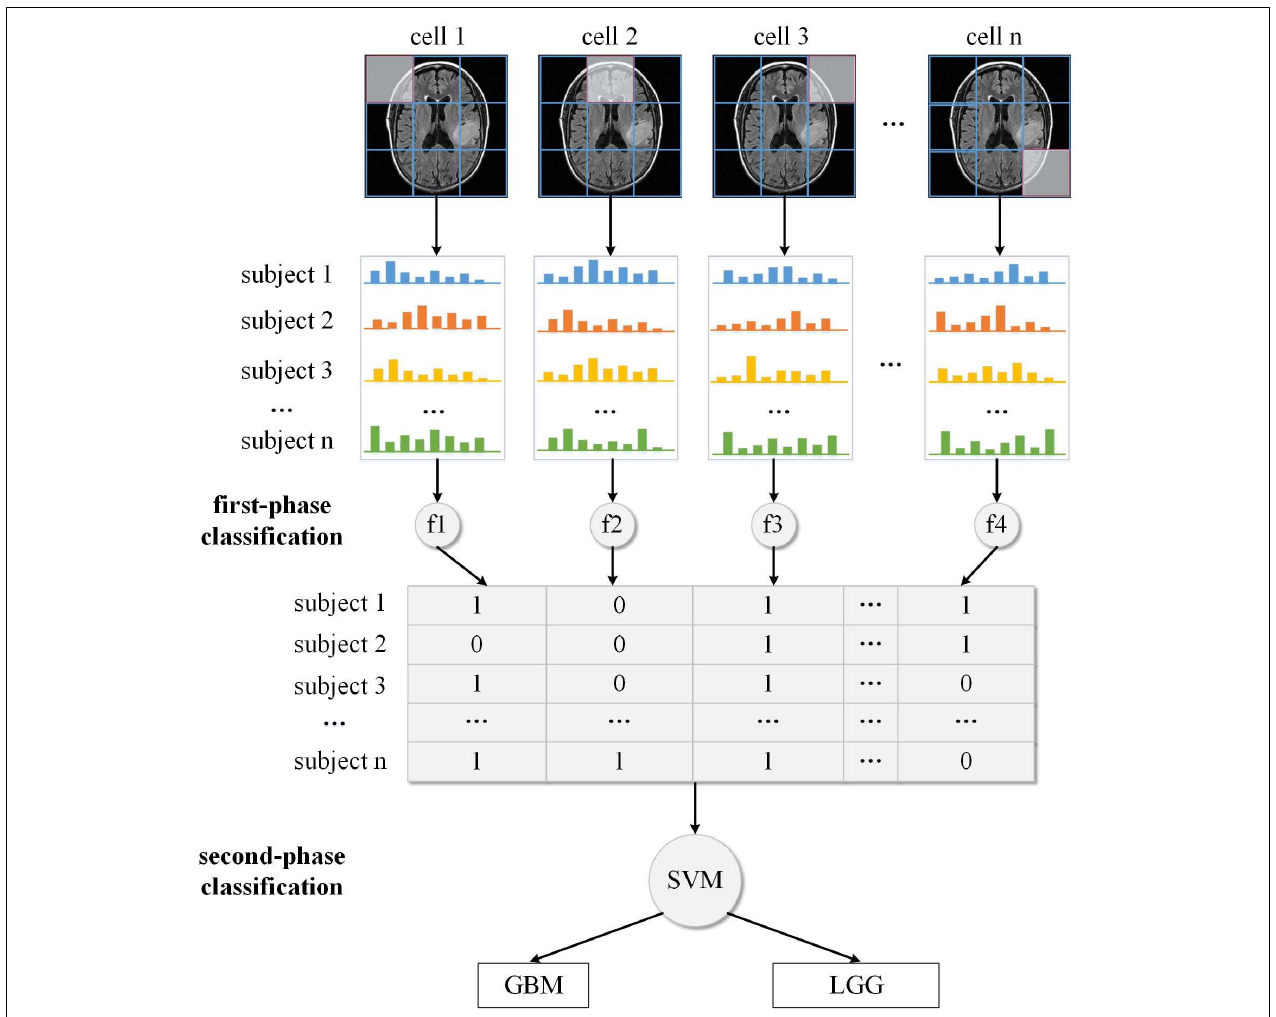
FIGURE 2 | The gradient-based two-phase classification